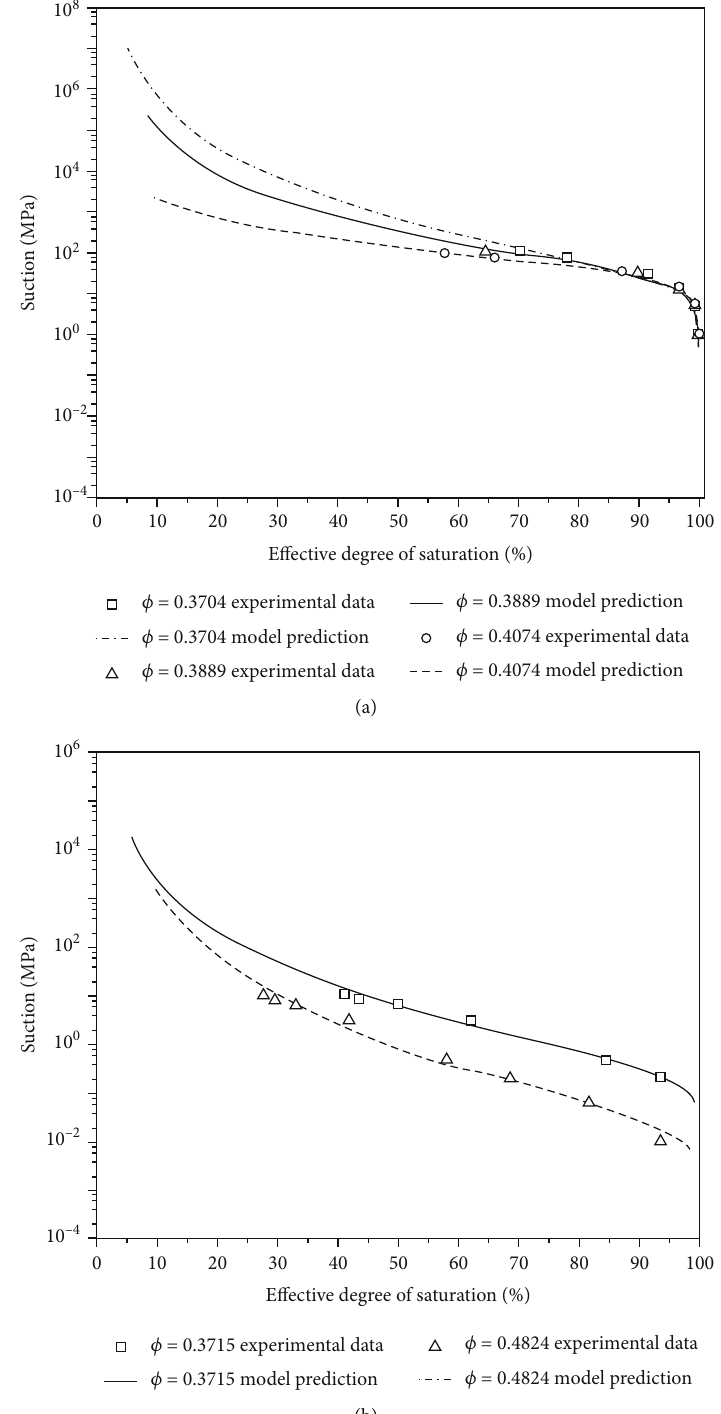
Figure 7: Comparison between model-predicted and literature results: (a) FEBEX bentonite and (b) Boom